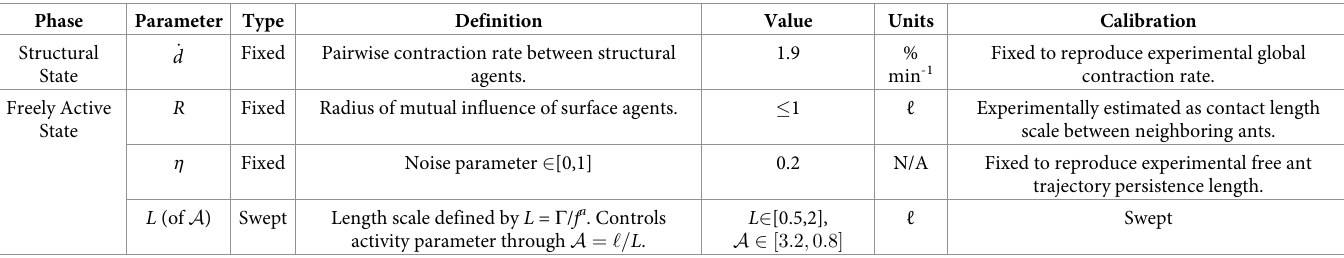
Table 2. Free parameters of model.